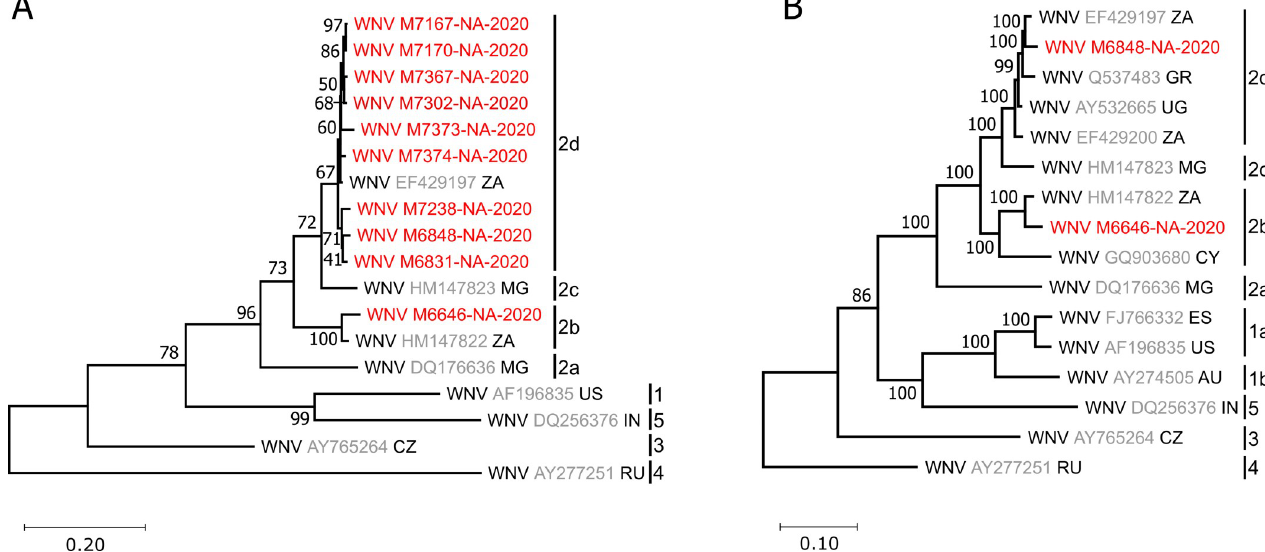
Fig 4. Phylogenetic relationship of detected WNV strains. The phylogenetic tree is based on a 1,032 nucleotide alignment of E-protein sequences of all detected WNV strains and selected global WNV strains (A) or on an alignment of the entire open reading frame (ORF) of WNV M6848-NA-2020 and M6646-NA-2020 and selected global WNV strains (B). Branch support is given for each branch. Virus sequences identified in this study are shown in red. Reference sequences are marked with their accession number in grey and the two-letter code of their countries of origin. AU, Australia; CY, Cyprus; CZ, Czechia; ES, Spain; GR, Greece; IN, India; MG, Madagascar; RU, Russia; UG, Uganda; US, United States of America; ZA, South Africa. The phylogenies are rooted to a WNV lineage 4 strain from Russia